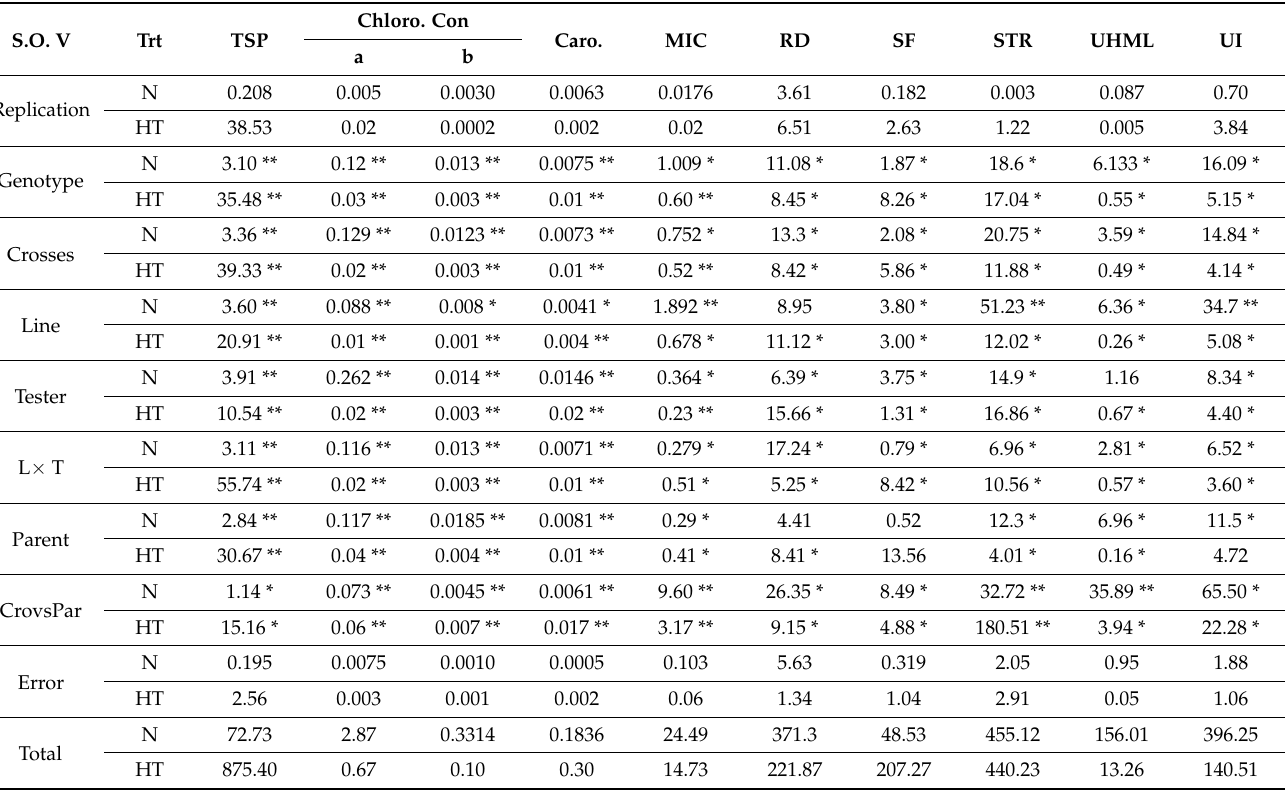
Table 5. First year mean squares of line × tester analysis for various characters under normal and high temperature stress